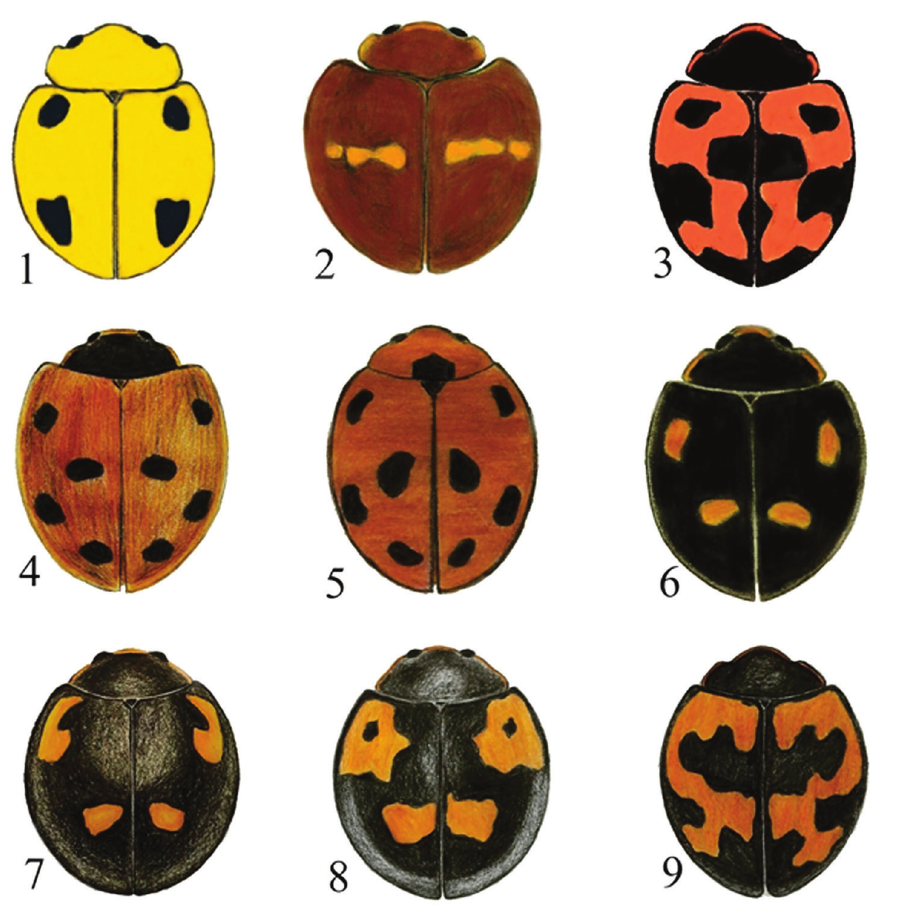
Figures 1–9. Dorsal habitus of Chilocorini species. 1 Brumoides adenensis Fürsch 2 Chilocorus bipustu- latus Linnaeus 3 E. ericae Crotch 4 E. gebleri Weise 5 E. octosignatus Gebler 6 E. quadriguttatus Fleischer 7, 8 E. quadripustulatus Linnaeus 9 E. undulatus Weise. 8 antennomeres; with scape symmetrical; 8 th antennomere either as long as or mark- edly longer than antennomere 7. Clypeus long; labrum partly exposed. Pronotal base unbordered; prosternal process narrow without carinae; hypomeral fovea absent. All tibiae flattened and angulate externally, without apical spurs; tarsal claws strongly ap- pendiculate. Elytral margin not reflexed with indistinct bead; epipleural foveae weak. Abdominal ventrite 6 visible in males; abdominal postcoxal lines separated medially, each running parallel to hind margin of ventrite (after Ślipiński